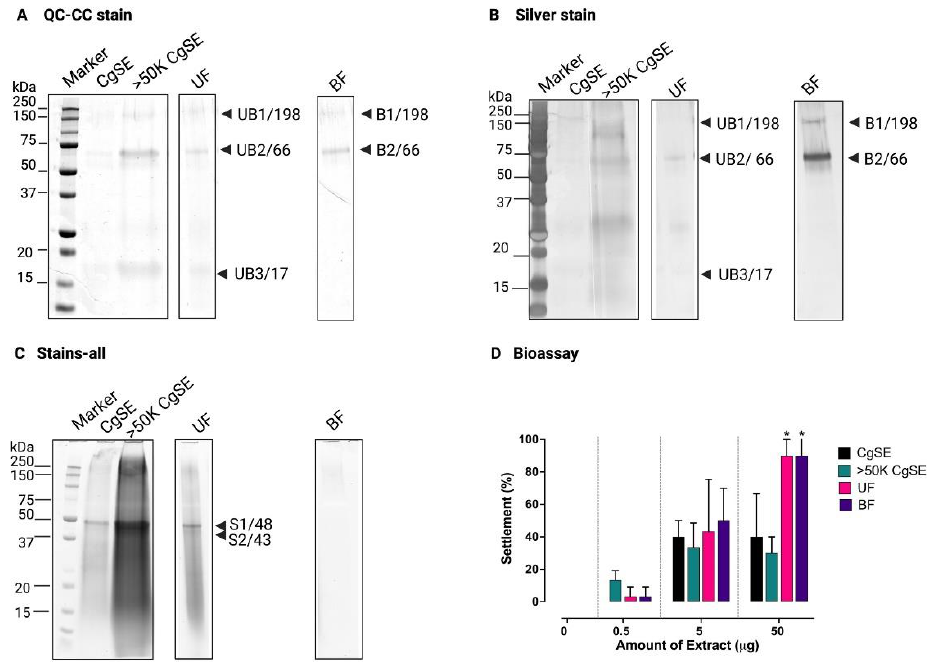
Figure 1. SDS-PAGE analyses and larval settlement responses to Crassostrea gigas EDTA-soluble shell matrix proteins and its fractions after elution from WGA lectin affinity chromatography. ( A – C ) SDS-PAGE profile of fractions eluted from WGA lectin affinity chromatography under different staining methods. ( D ) Settlement percentages of C. gigas larvae response with varying amounts of different forms of CgSE and fractions eluted after WGA affinity chromatography. All larvae were exposed to the settlement- inducing cue for 24 h. Asterisks “*” indicate significant differences among varied forms of CgSE determined via quasi-binomial glm ( p < 0.05). Missing bars in the figure indi- cate no settlement. Data are the means (SD) of three replicates. Abbreviations: UF, Unbound frac- tion; BF, Bound fraction; UB1-UB3, B1, B2, S1, and S2 bands correspond to the identified proteins in the mass spectrometry analyses and are summarized in Table 1. This figure was created using Bio- Render.com (accessed on 25 July 2022) and GraphPad 9 software program. Table 1 . Identification of the EDTA-soluble shell matrix proteins of Crassostrea gigas by Peptide Mass Fingerprinting Analysis in the unbound and bound fractions eluted after WGA affinity chromatog- raphy. Band No.